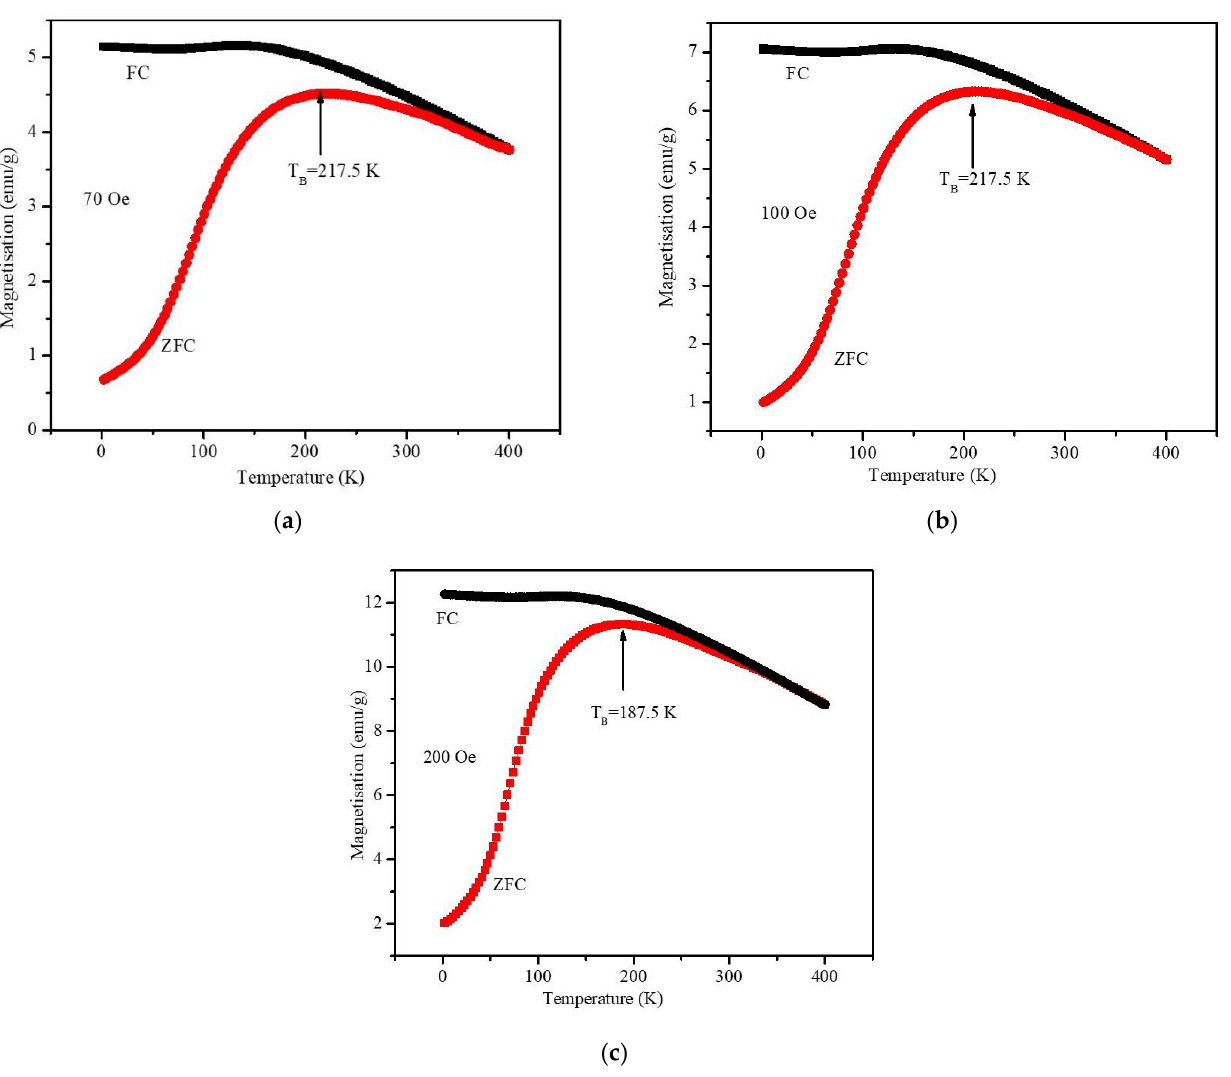
Figure 3. ZFC and FC plots obtained under field ( a ) 70, ( b ) 100, and ( c ) 200 Oe. (The arrows indicate the blocking temperature of the nanoparticles).